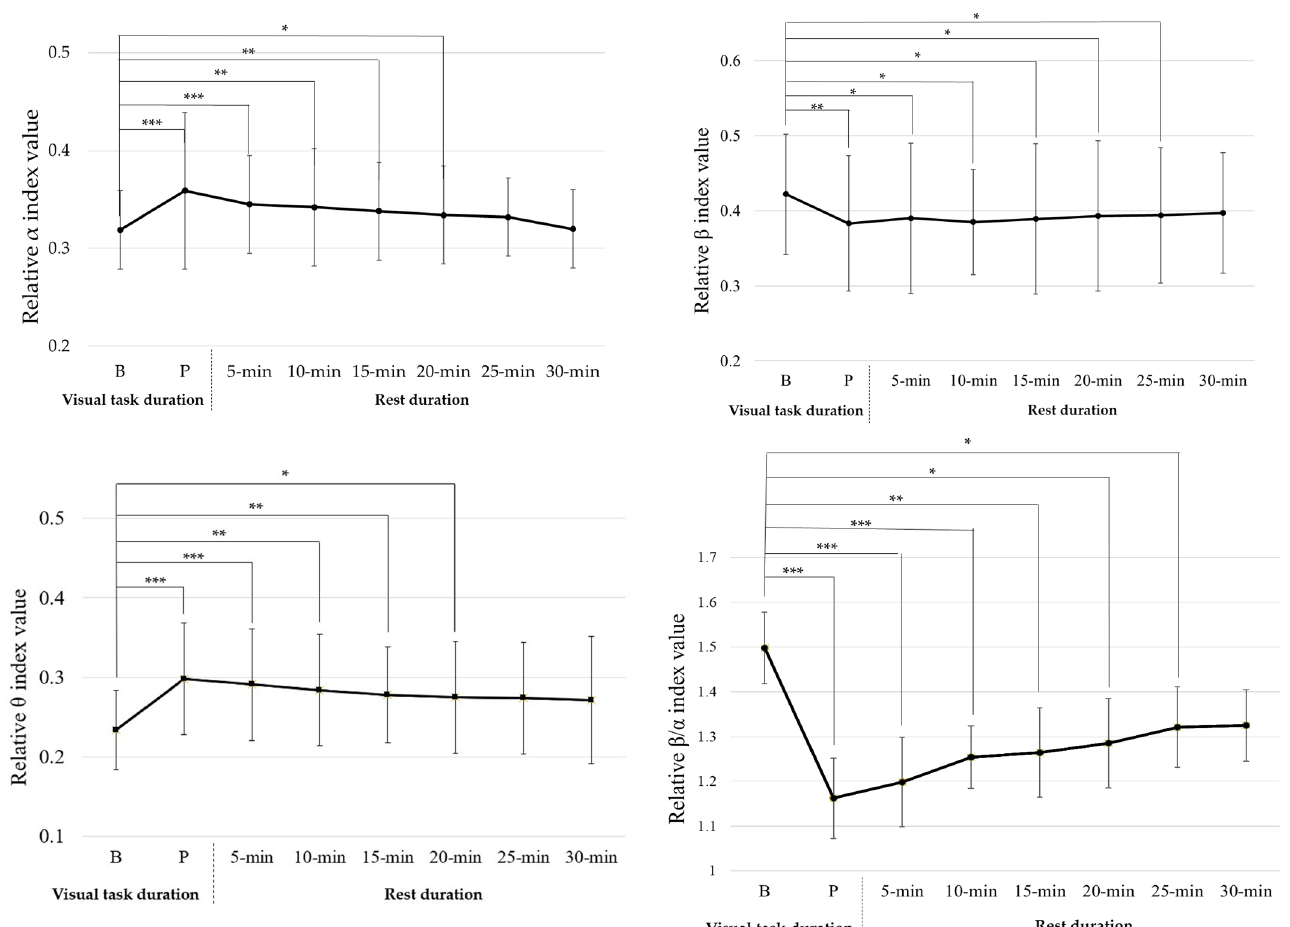
Figure 4. Wilcoxon signed-rank test results for 4 EEG relative power indices for 15 min visual task baseline, post-experiment, and rest time. Note: B: Baseline, P: Post-experiment, * p < 0.05; ** p <0.01; *** p <